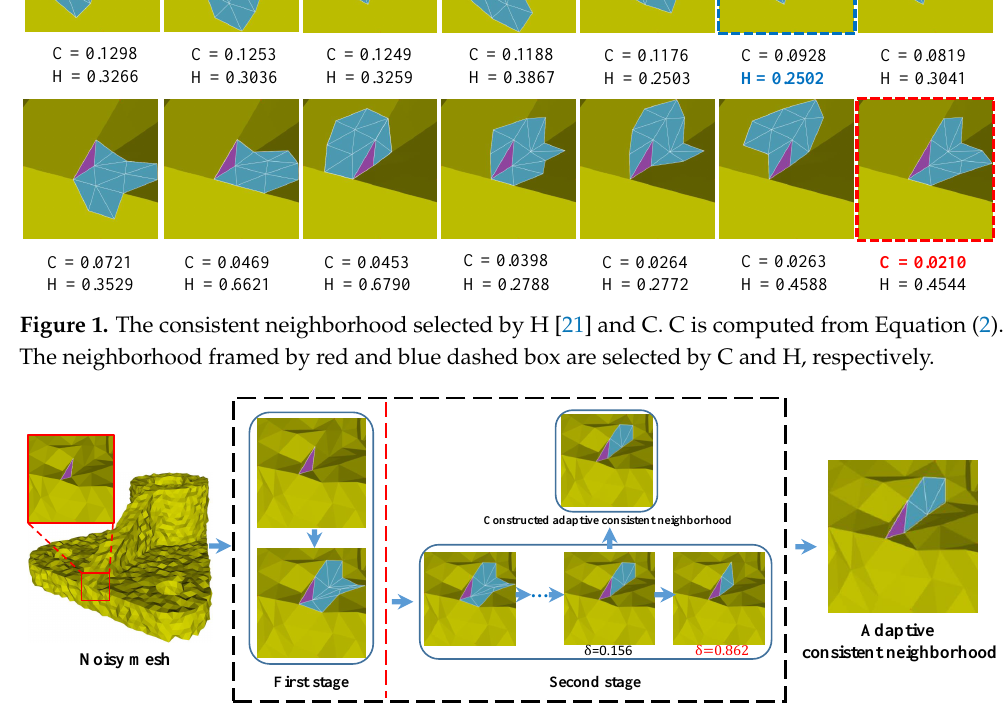
Figure 2. The pipeline of the proposed two-stage method for constructing adaptive consistent neighborhood. In the first stage, for a face (in purple), we compute a coarse consistent neighborhood by using patch-shift method with the proposed consistency measure. In the second stage, we propose a graph-cut based scheme for iteratively refining the obtained coarse consistent neighborhoods in a shape-aware